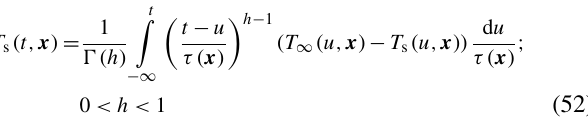
Characteristic meridional variation